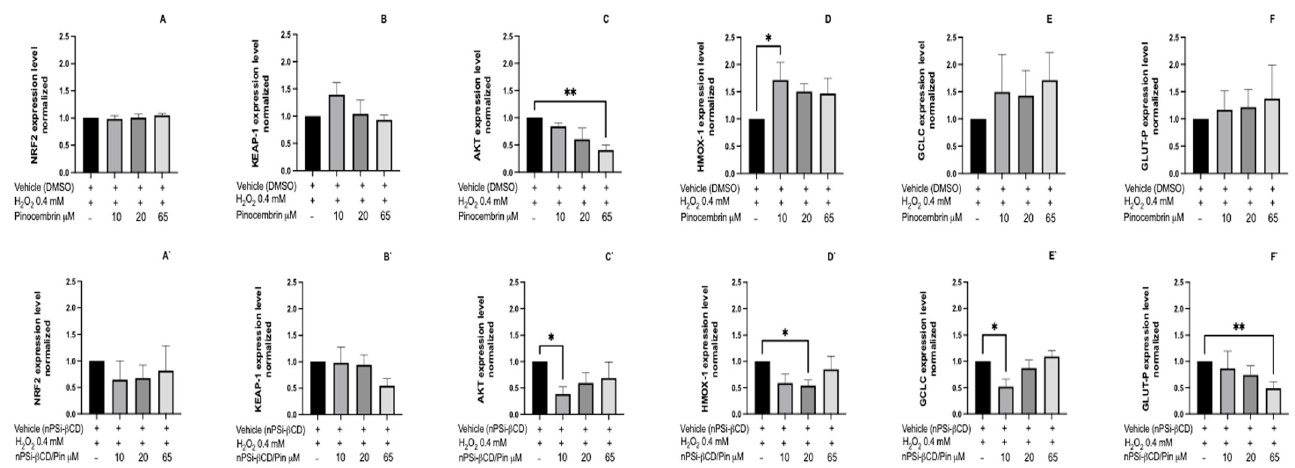
Figure 10. Effect of treatment with pinocembrin on the expression of genes related to the antioxidant pathway. HUVECs were stimulated with 0.4 mM H 2 O 2 and treated with pinocembrin at concentra- tions of 10, 20, and 65 µ M for 8 h. ( A – F ): Treatments with pinocembrin in solution. ( A‘ – F‘ ): treatments with pinocembrin loaded in the nPSi- β CD composite microparticle. The data were normalized against RPL-30 and GAPDH. The bars represent the mean expression for each group ± standard deviation. The number of asterisks reflects differences between vehicle vs. treatments (* = p < 0.05; ** = p < 0.01; n = 3).